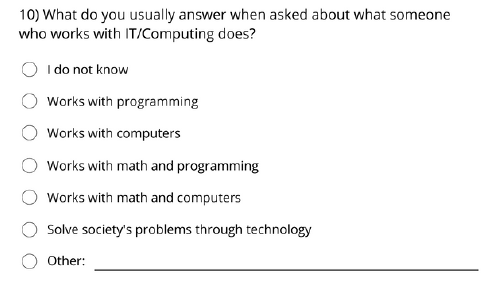
Figure 1 . Answers to the question “What do you usually answer when asked about what someone who works with IT/Computing